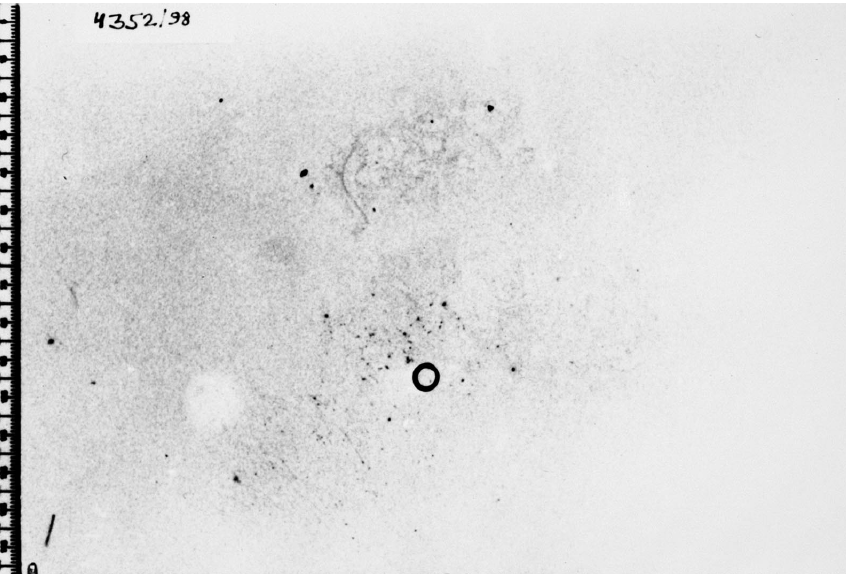
FIGURE 6 . Black and white photograph of the visualized total nitrite pattern on the adhesive lifter applied to the gunshot wound of Fig. 5. The location of the bullet entrance hole is marked with a